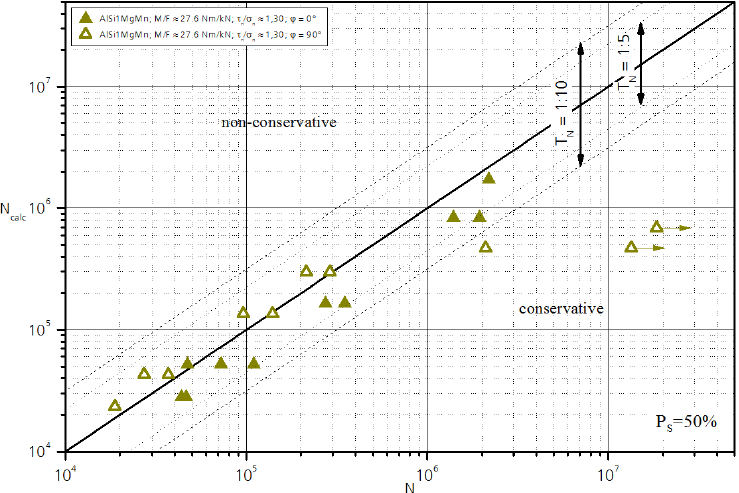
Figure 10: Experimental results for the EN AW 6082 T6 alloy. Experimental vs. calculated (MWCM) fatigue life. Results obtained using EESH according to Sonsino